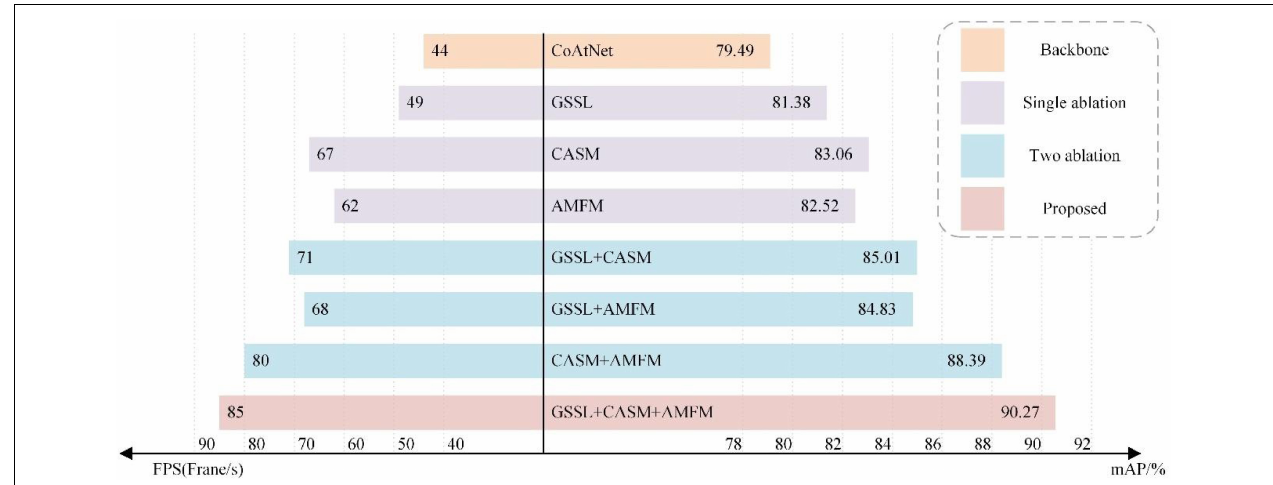
FIGURE 10 | Ablation experiments.